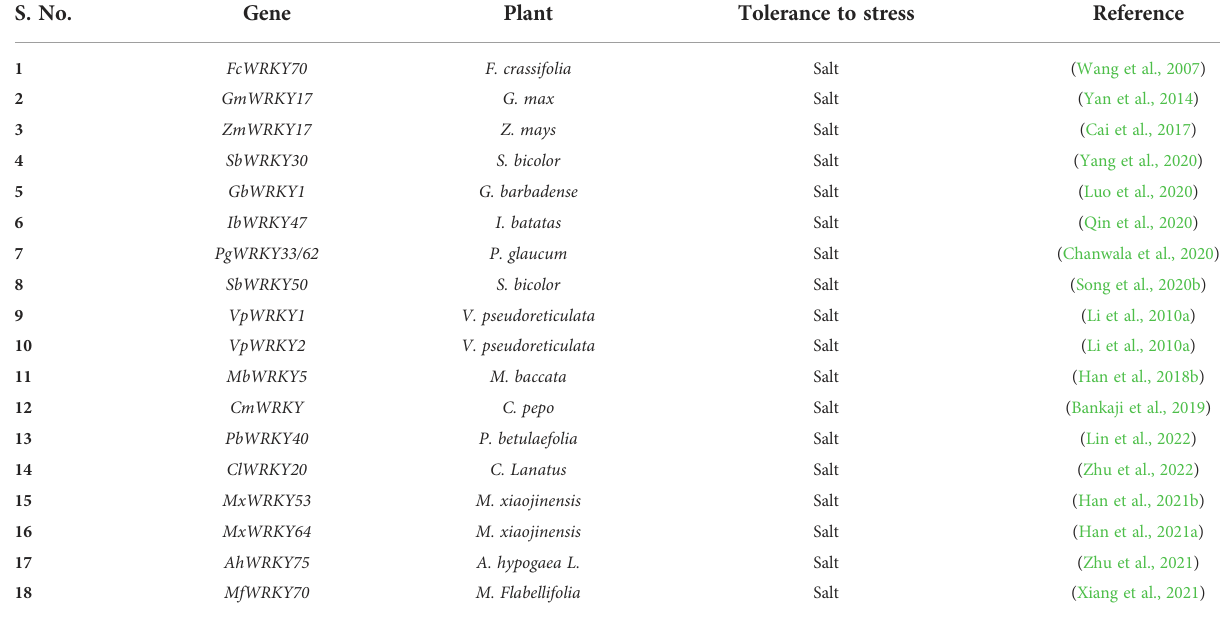
TABLE 5 Salinity stress-related WRKY